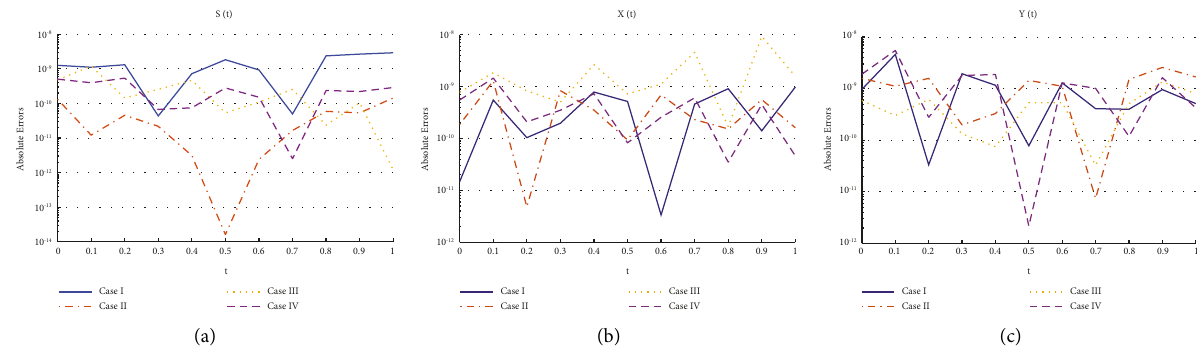
Figure 19: Absolute errors obtained by the LeNN-WOA-NM algorithm under the influence of variations in c the prey-predator model. (a) Population density of local prey. (b) Population density of immigrant prey. (c) Population density of the predator.